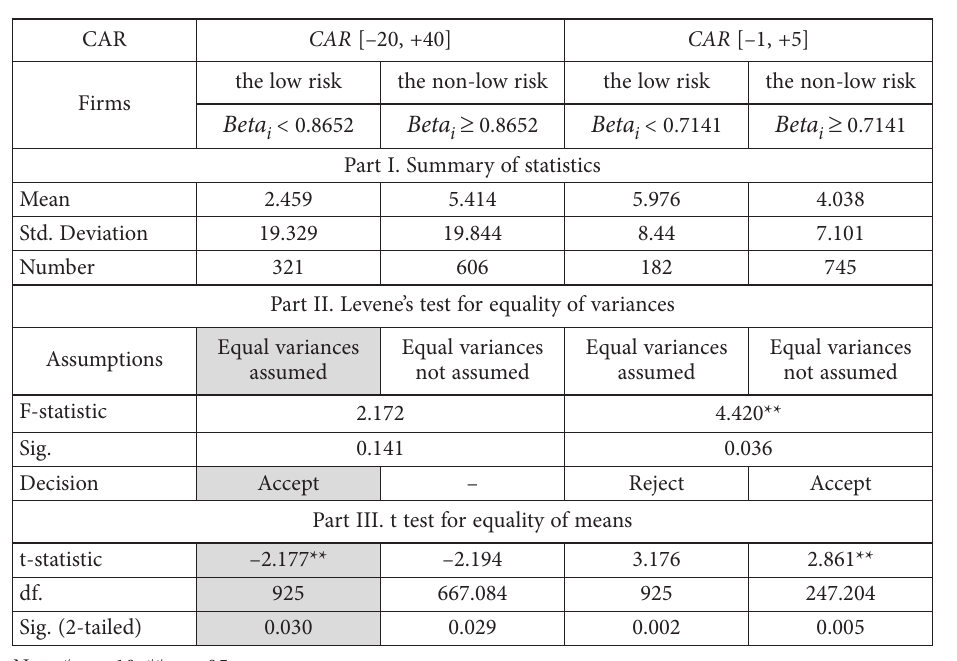
Table 6. The difference analysis of the low v.s. non-low systematic risk